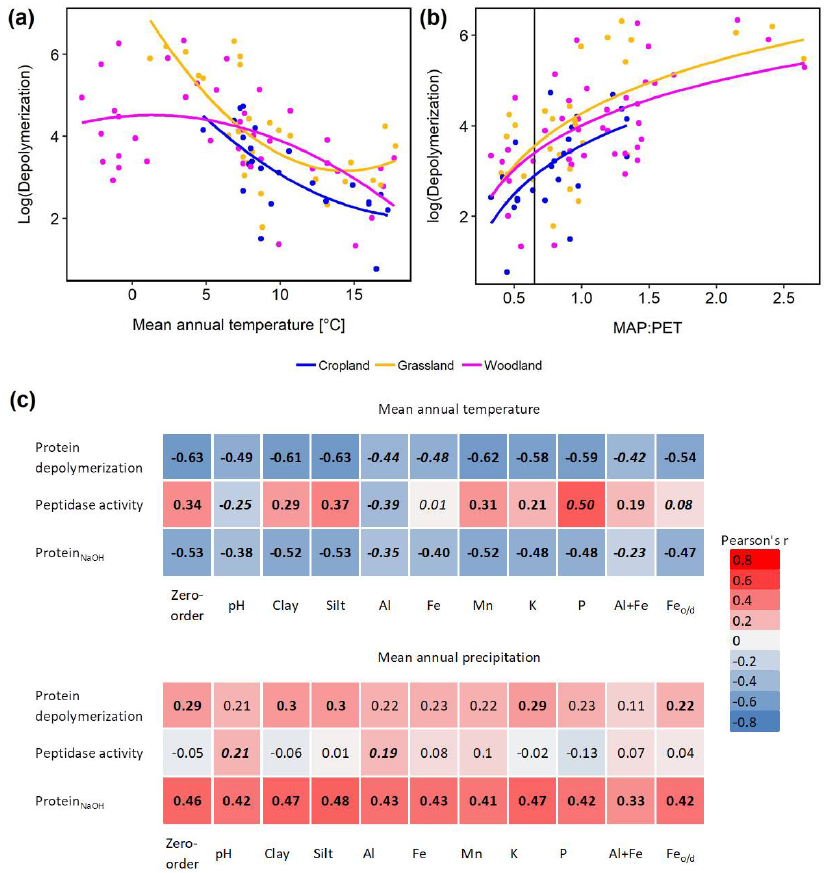
Figure 4. Climate effects on gross protein depolymerization. (a) Relationship between the natural logarithm of gross protein depolymeriza- tion and second polynomial regression fit for cropland (adjusted r 2 = 0 . 455, p < 0 . 001, n = 24), grassland ( r 2 = 0 . 480, p < 0 . 001, n = 28) and woodland ( r 2 = 0 . 219, p < 0 . 01, n = 48) soils. (b) Relationship between the natural logarithm of gross protein depolymerization rates and the ratio of mean annual precipitation over potential evapotranspiration (MAP:PET) and regression fit ( y = log (x) ) for cropland (ad- justed r 2 = 0 . 330, p < 0 . 01, n = 24), grassland (adjusted r 2 = 0 . 371, p < 0 . 001, n = 28) and woodland (adjusted r 2 = 0 . 318, p < 0 . 001, n = 48) soils. The vertical line indicates the transition from arid to humid climate conditions (MAP:PET = 0.65). (c) Zero-order and par- tial correlations (Pearson’s r ) between climate variables (MAT and MAP) and organic N cycling (protein depolymerization rate, leucine aminopeptidase activity and Protein NaOH ) controlled for geochemical variables). Significant correlations are indicated by bold numbers. Significant changes of the correlation coefficients compared to the zero-order correlation are indicated by italic